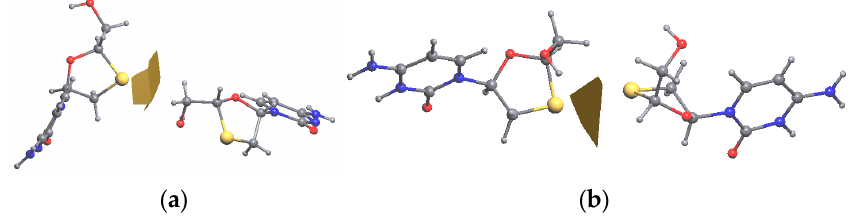
Figure 10. Intermolecular S…H and S…S. interactions and the corresponding surface of Voronoi polyhedra in crystals of ( a ) 3TC·0.5H 2 O [18] and ( b ) H3TC(C 2 O 4 )·0.5H 2 O [24].